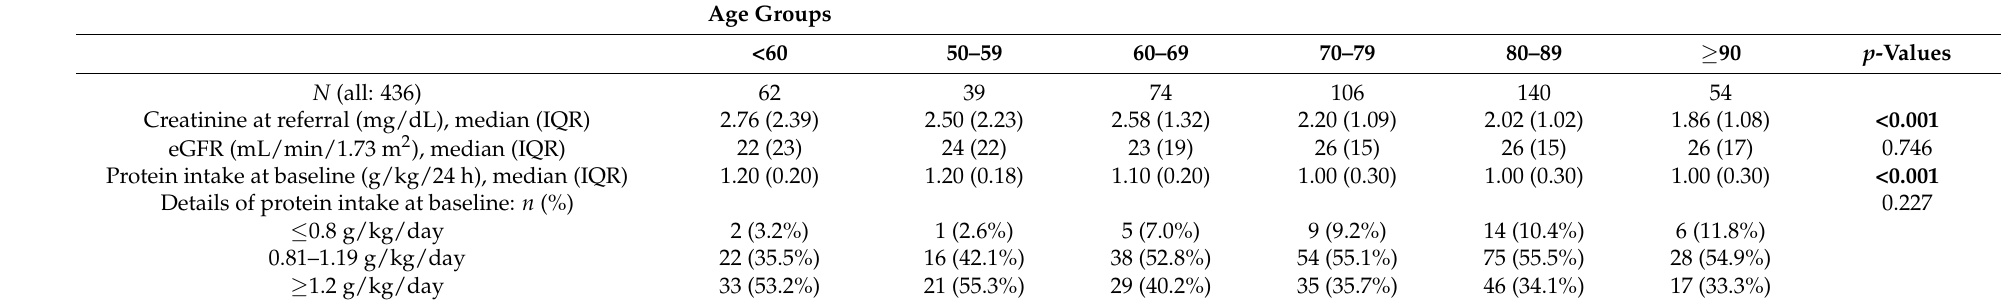
Table 3. Protein intake in different age groups of CKD stage 3–5